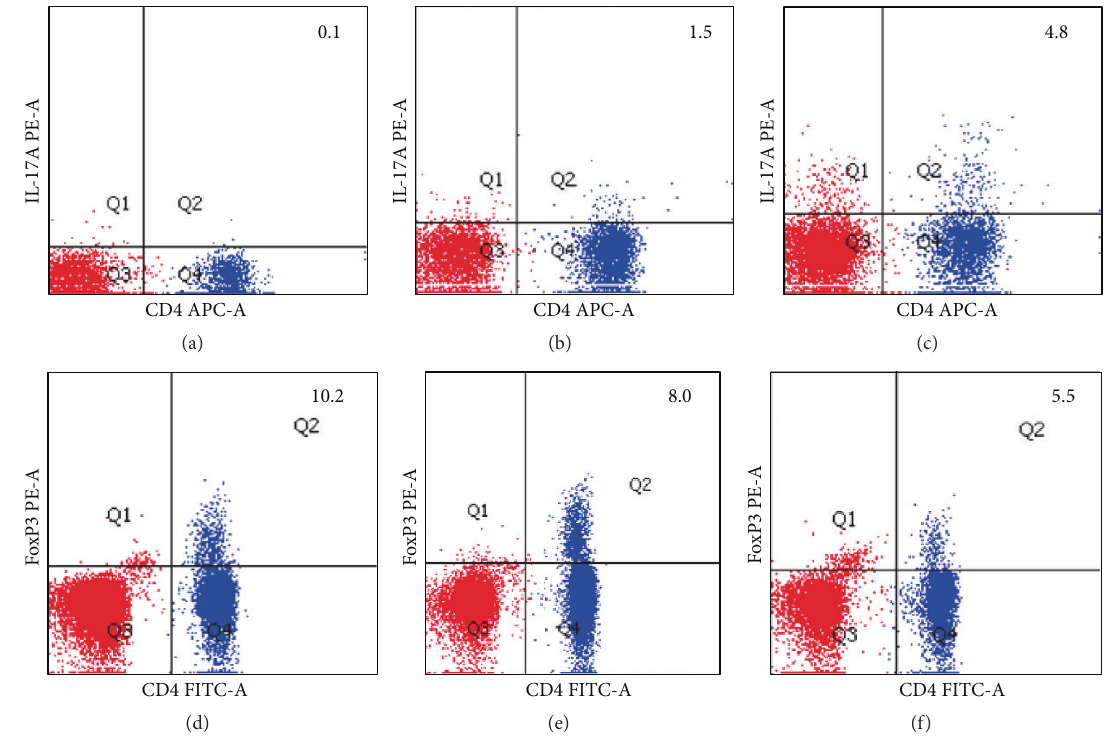
Figure 3: Flow cytometric analysis of the percentage of Th17 and Treg cells in peripheral blood. (a) Percentage of Th17 in peripheral blood in healthy control subjects. (b) Percentage of Th17 in peripheral blood in mild type subgroup of UC patients. (c) Percentage of Th17 in peripheral blood in moderate and severe type subgroup of UC patients. (d) Percentage of Treg cells in peripheral blood in healthy control subjects. (e) Percentage of Treg cells in peripheral blood in mild type subgroup of UC patients. (f) Percentage of Treg cells in peripheral blood in moderate and severe type subgroup of UC patients. In (a), (b), and (c), in the quadrant 1 (Q1), the IL-17A PE-A antibody is positive; the CD4 APC-A antibody is negative; in Q2, both the IL-17A PE-A and CD4 APC-A antibody are positive; in Q3, both the IL-17A PE-A and CD4 APC-A antibody are negative; in Q4, the IL-17A PE-A antibody is negative; the CD4 APC-A antibody is negative. In (d), (e), and (f), in Q1, the foxP3 PE-A antibody is positive; the CD4 FITC-A antibody is negative; in Q2, both the foxP3 PE-A and CD4 FITC-A antibody are positive; in Q3, both the foxP3 PE-A and CD4 FITC-A antibody are negative; in Q4, the foxP3 PE-A antibody is negative; the CD4 FITC-A antibody is